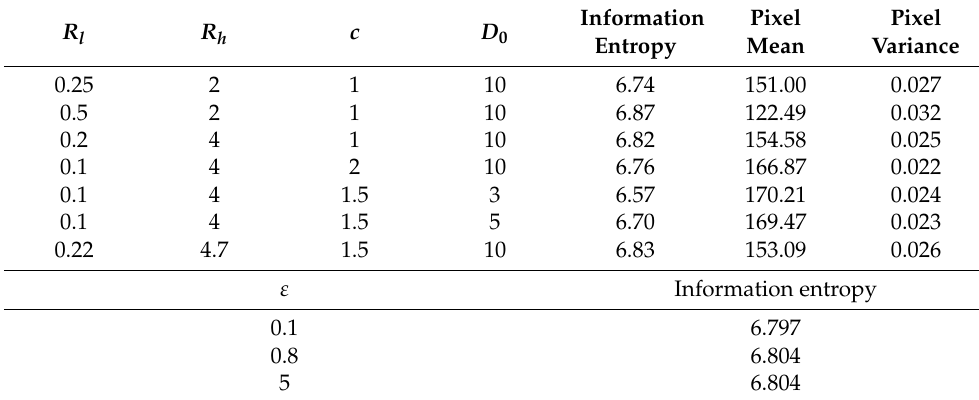
Table 1. Experimental results of filtering parameters.